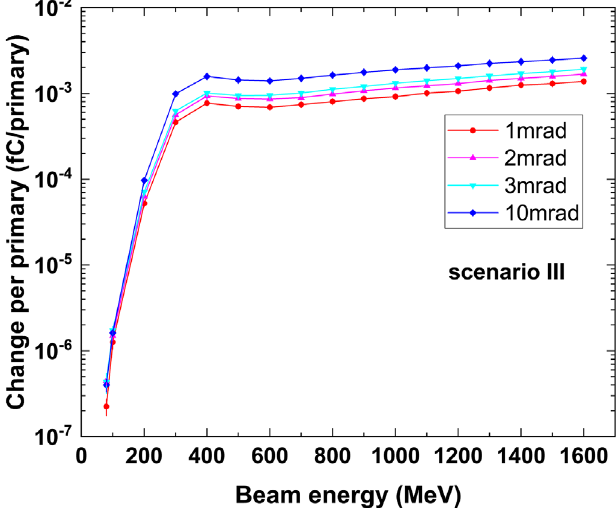
FIG. 20. The impact-angle dependence of BLM responses for scenario III, and the angle varies from 1 to 10 mrad.